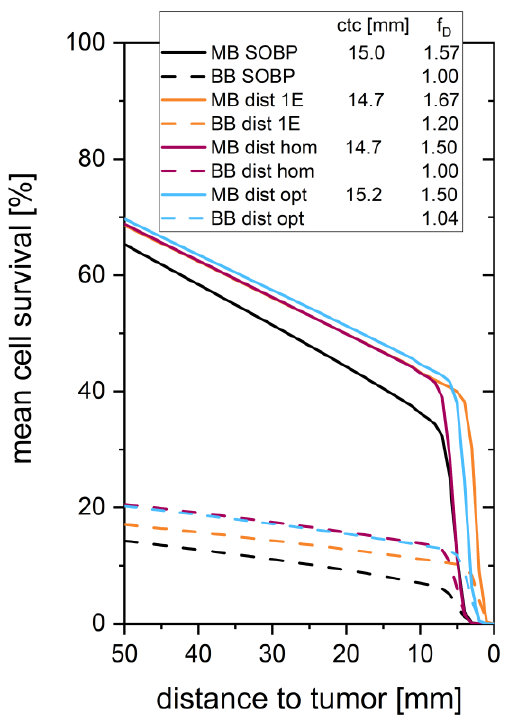
Figure 5. Mean cell survival over the distance to tumor for a prescribed tumor dose D t = 10 Gy (solid lines for interlaced minibeam irradiation (MB), dashed lines for broadbeam irradiation (BB)). The different applied depth-doses are color marked with black, orange, purple, and blue for SOBP, 1E, HOM, and OPT, respectively.